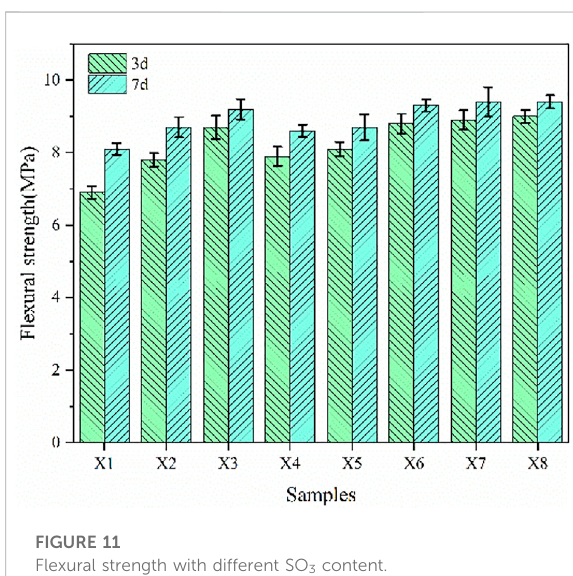
FIGURE 11 Flexural strength with different SO 3